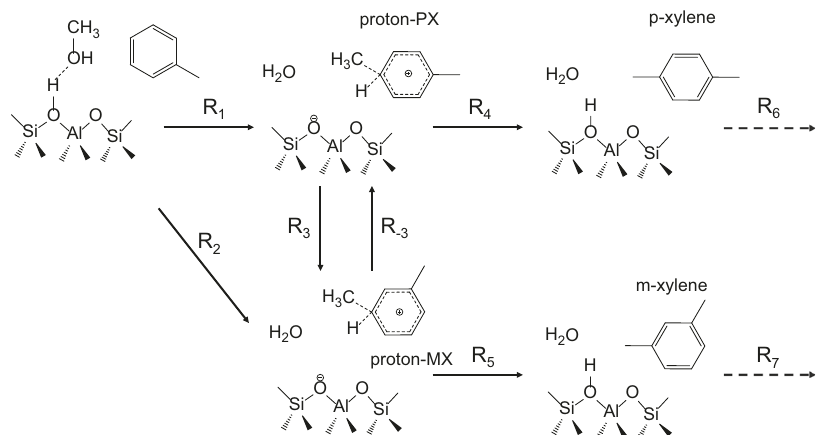
Fig. 1 Reaction pathways of toluene methylation in the pores of HZSM-5. The steps considered here include the methylation of toluene to proton – PX (R 1 ) and proton – MX (R 2 ), the isomerization between proton – PX and proton – MX (R 3 and R − 3 ), the deprotonation of proton – PX and proton – MX to p-xylene (R 4 ) and m-xylene (R 5 ), respectively, and the diffusion of these two products (R 6 and R 7